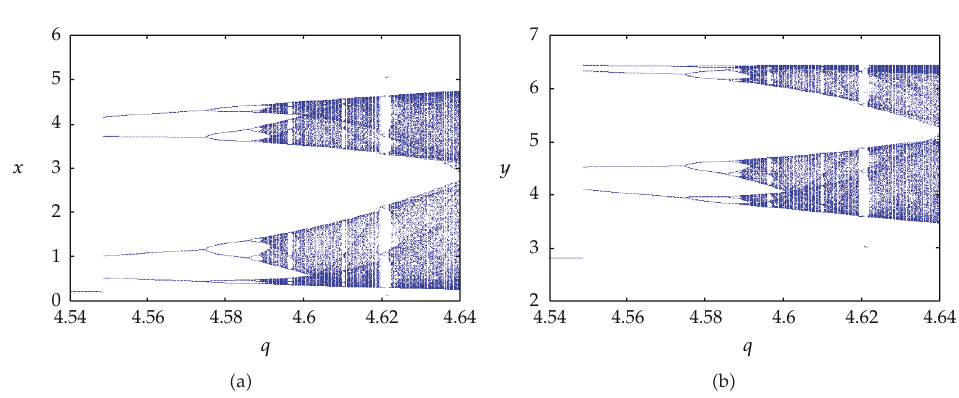
Figure 4: Bifurcation diagrams of (cid:3) 1.3 (cid:4) for q ranging from 4 . 54 < q < 4 . 64. (cid:3) a (cid:4) x is plotted. (cid:3) b (cid:4) y is plotted.